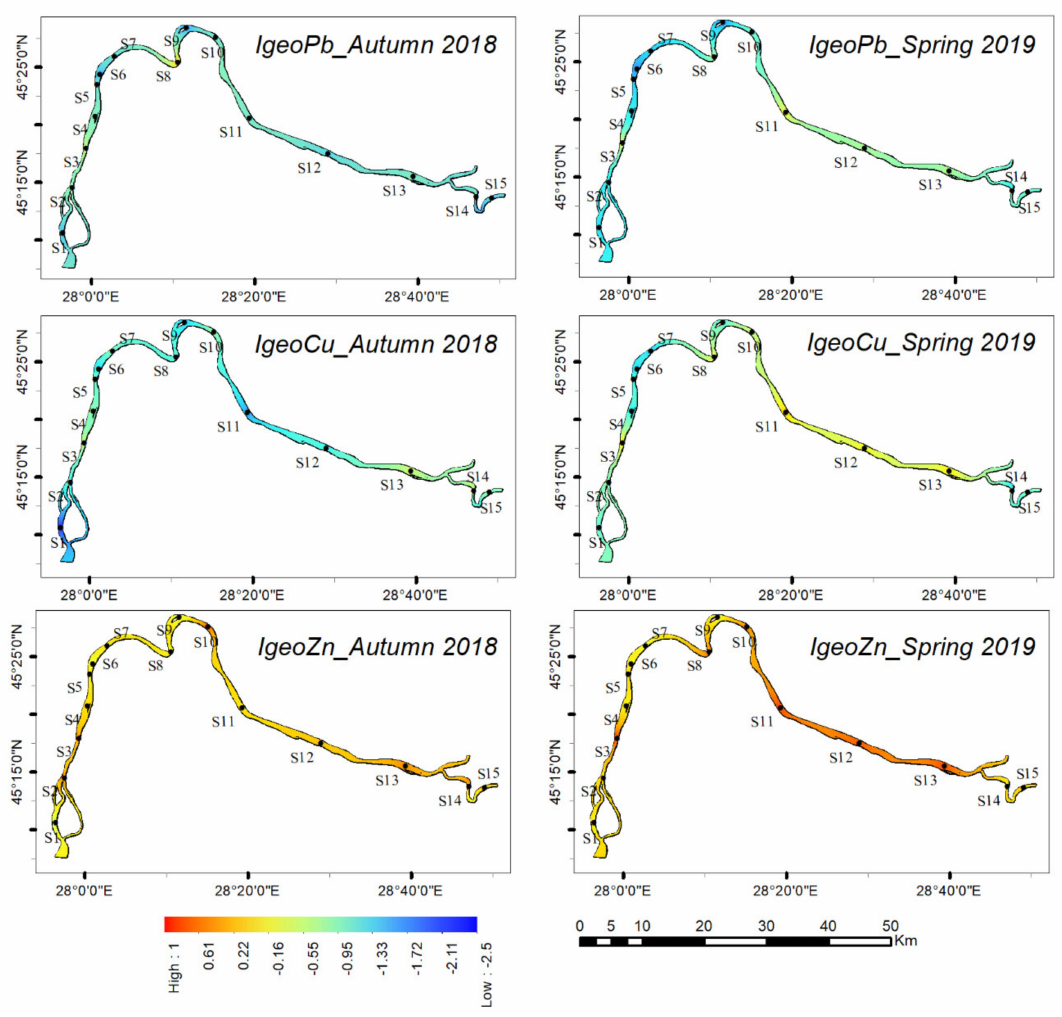
Figure 2. Spatial distribution of the Igeo for Cd, Ni, Pb, Cu and Zn in the autumn of 2018 and the spring of